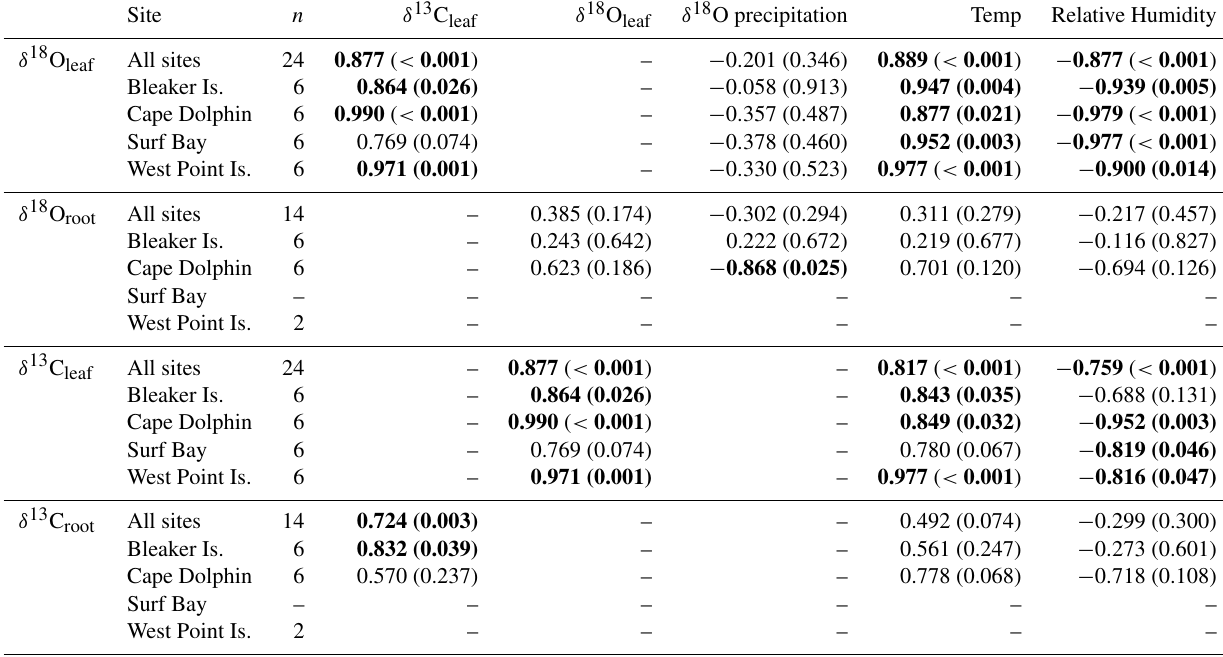
Table 1. Correlation coefficients (Pearson’s r ) of δ 18 O and δ 13 C in leaf and root cellulose between δ 18 O in monthly composite precipitation, monthly average temperature, and humidity by site.